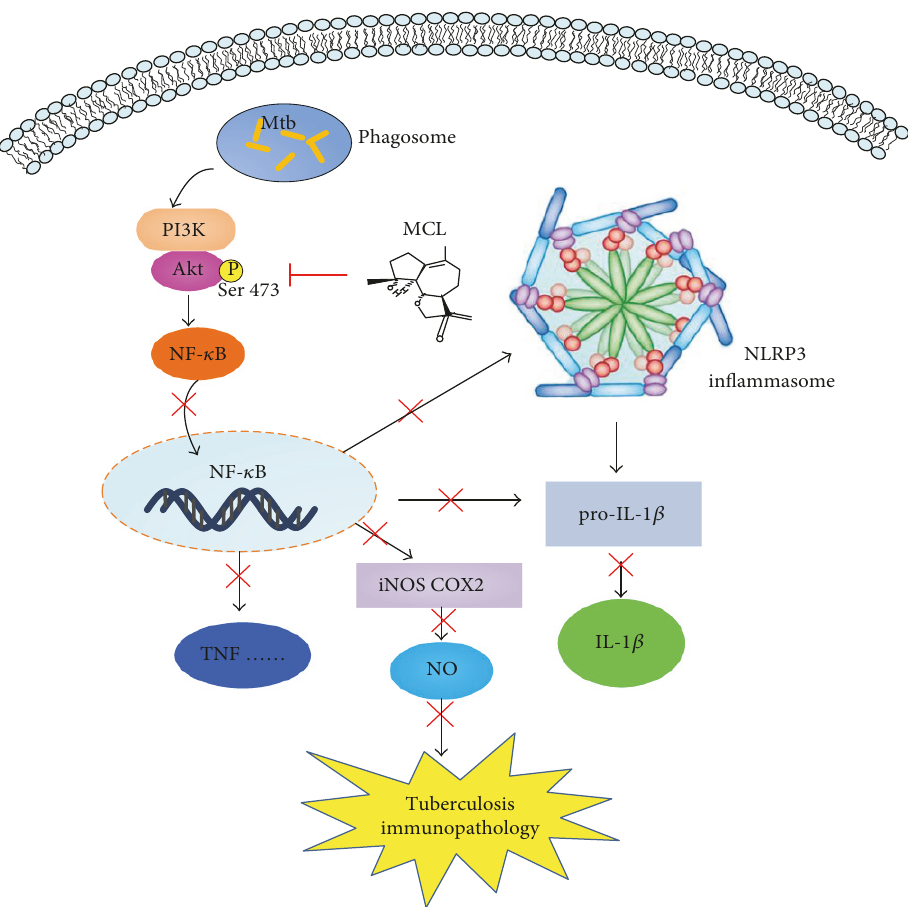
Figure 8: Illustration of the mechanism underlying the inhibitory e ff ect of MCL on Mtb-induced immunopathologic response. MCL can suppress the phosphorylation of Akt causing the subsequently inhibitory e ff ect on NF- κ B and NLRP3 in fl ammasome, which then impair the production of proin fl ammatory cytokines and fi nally alleviate tuberculosis